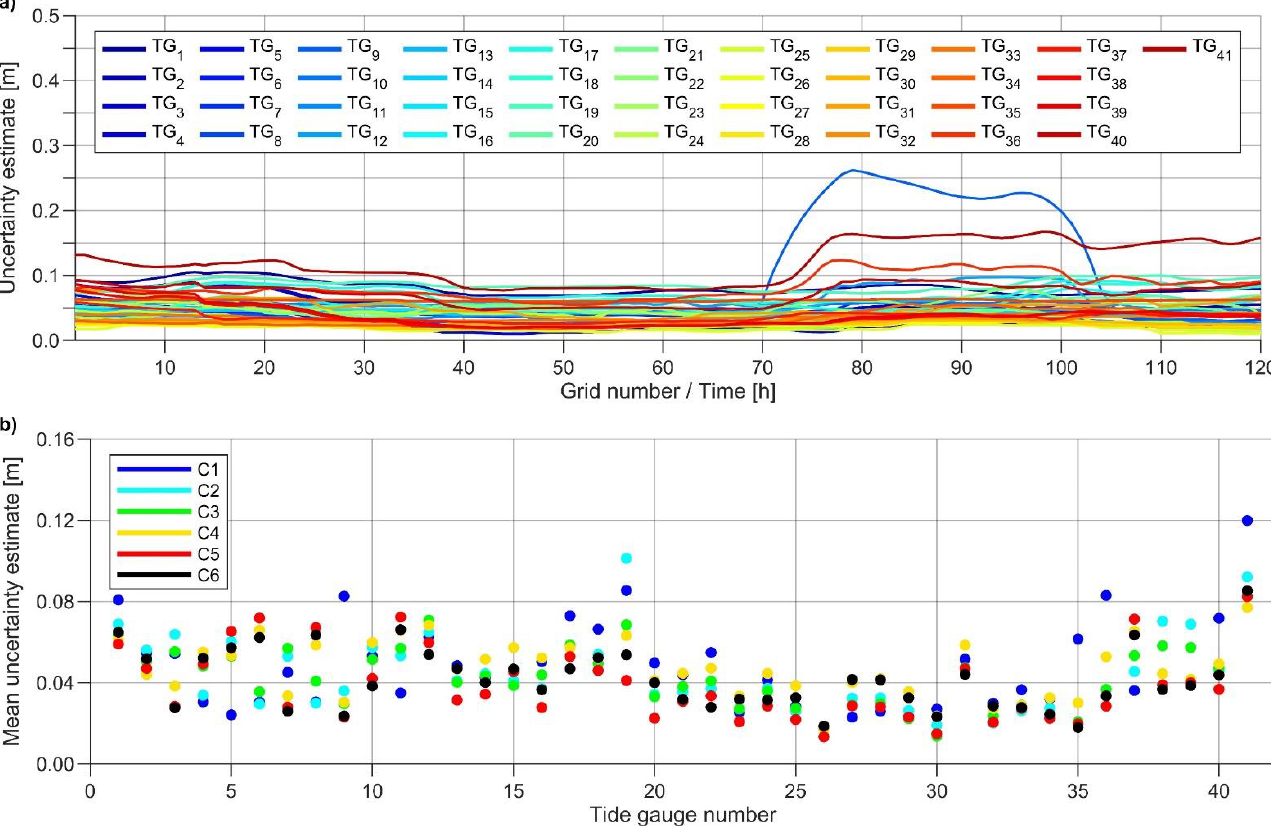
Figure 5. Uncertainty estimates of DB ( a ) at each TG station (refer to Figure 2) during the C1 campaign (cid:0) (cid:1) t H (i.e., σ DB ; cf. Equation (12)) and ( b ) averaged for all